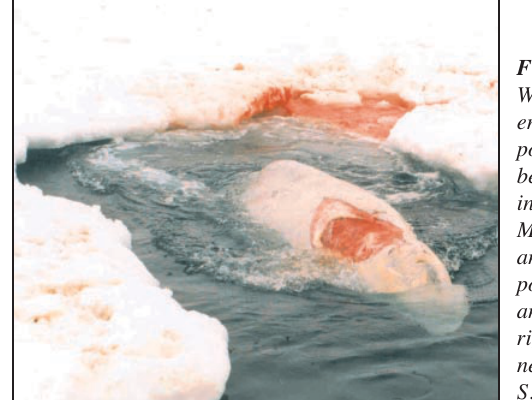
Wounds from encounters with polar bears on belugas entrapped in Jones Sound in May 1999. This animal has lost a portion of the skin and blubber on its right side of the neck (Photo: S.